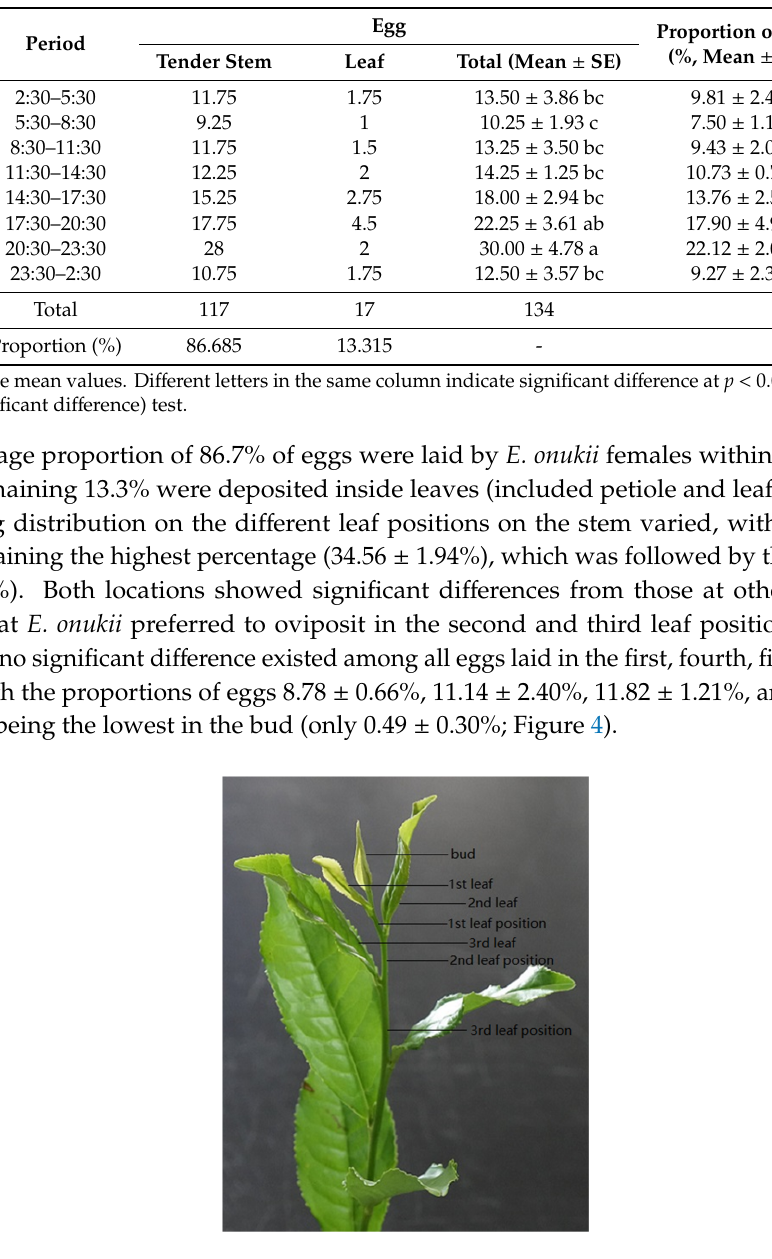
Figure 3. Configuration of the leaf positions on a tender tea shoot. The first leaf position was between the first and second leaf nodes, the second leaf position was between the second and third leaf nodes, the third leaf position was between the third and fourth leaf nodes, and by parity of reasoning for the other leaf positions.